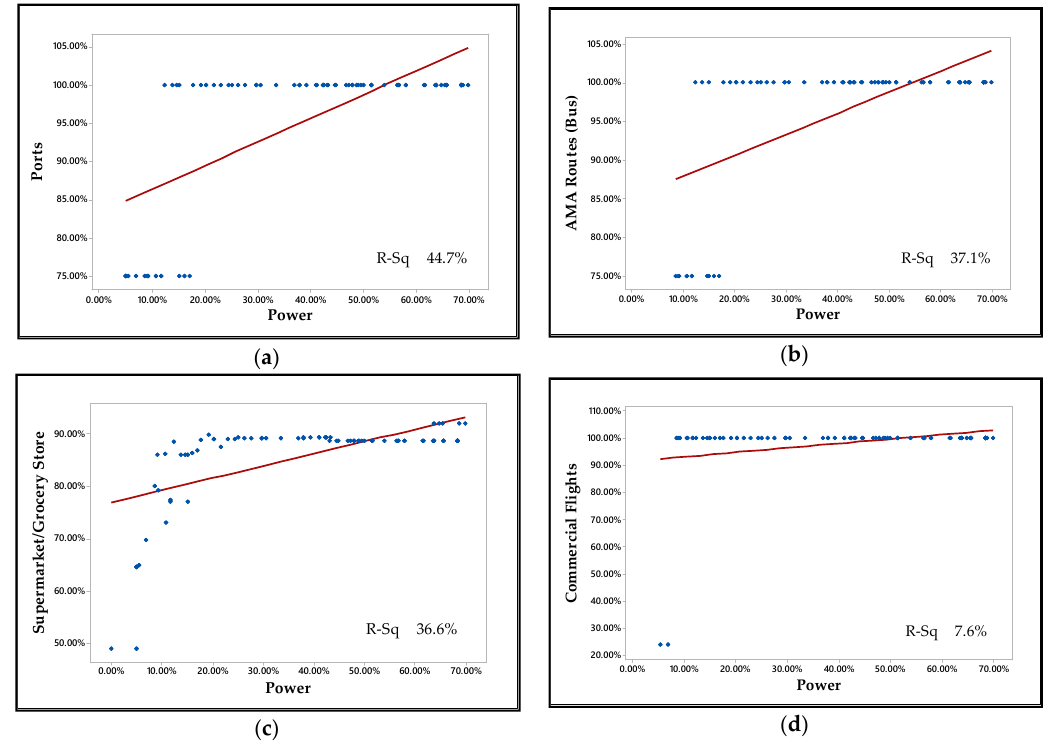
Figure 6. Infrastructure interdependency of ( a ) ports; ( b ) AMA routes; ( c ) supermarket/grocery stores; and ( d ) commercial flights systems, with power systems infrastructure, based on post-disaster recovery patterns after Hurricane Maria.